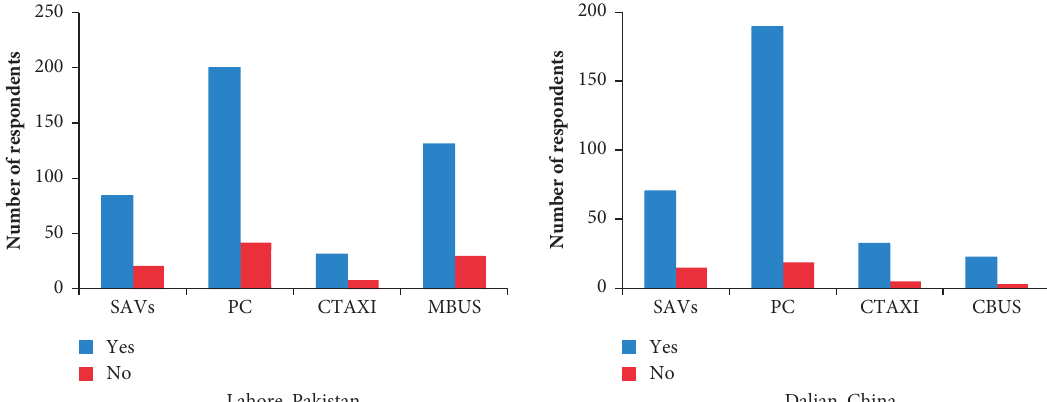
Figure 9: Preferences of shared mobility interested individuals to shopping trips.